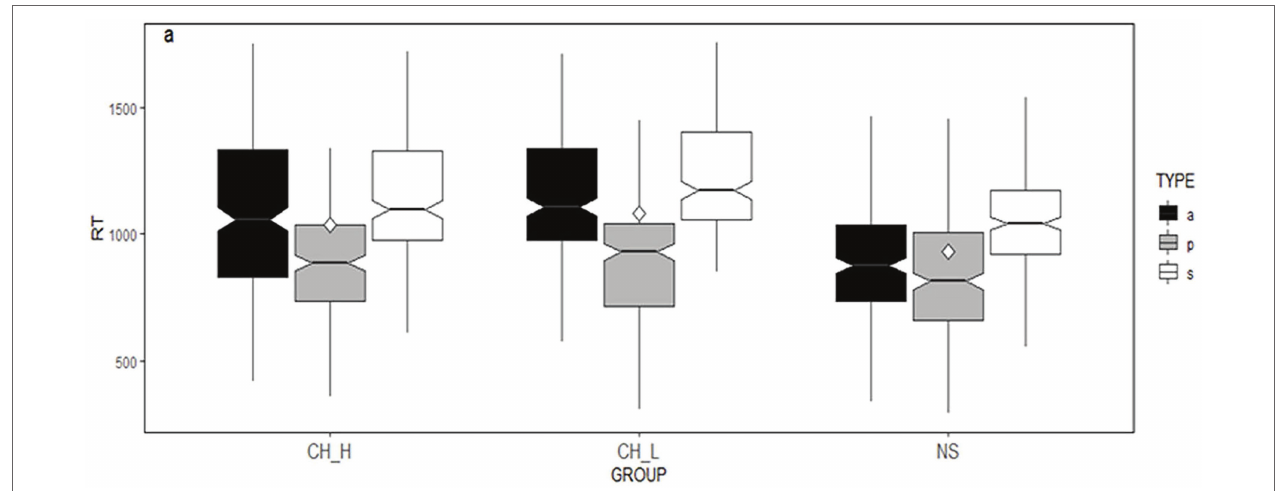
FIGURE 2 | Box plots of the corresponding RTs by lexical aspect in the past tense at the critical region for the three groups. a, activity verbs; p, achievement verbs; and s, state